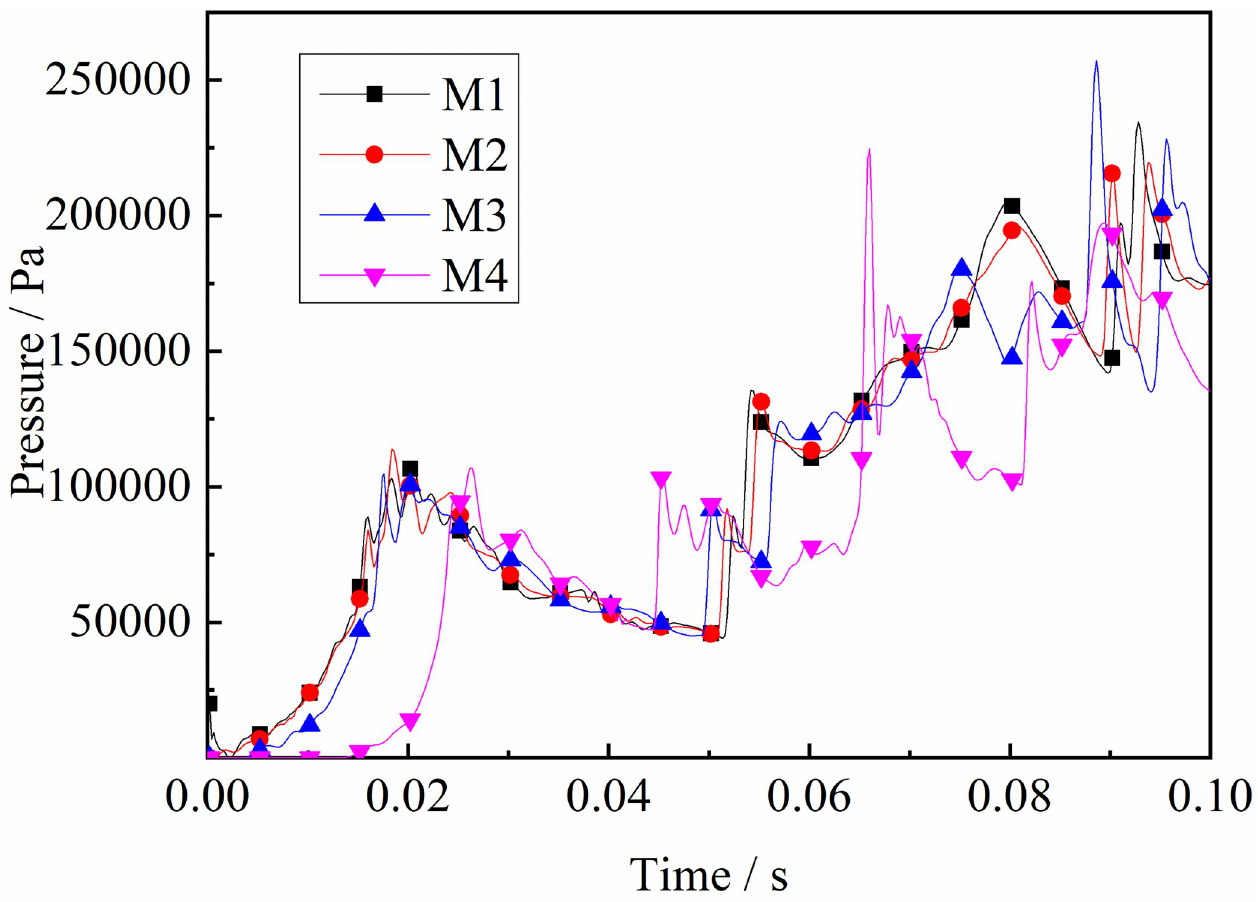
Fig 12. Pressure—Time curves at the monitoring point M1-M4 (gas concentrations 9.5%).